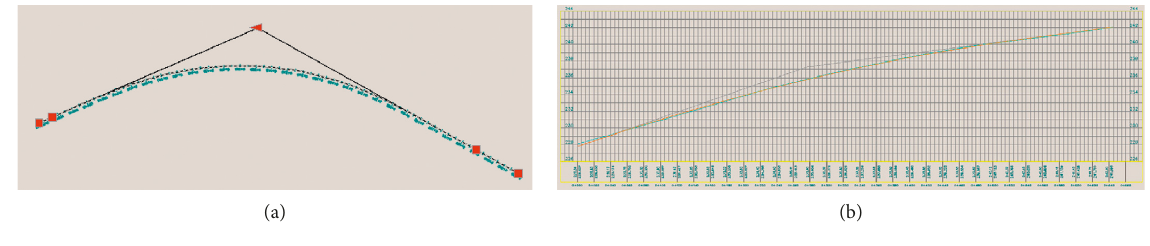
Figure 3: Fitting of horizontal and vertical alignment.